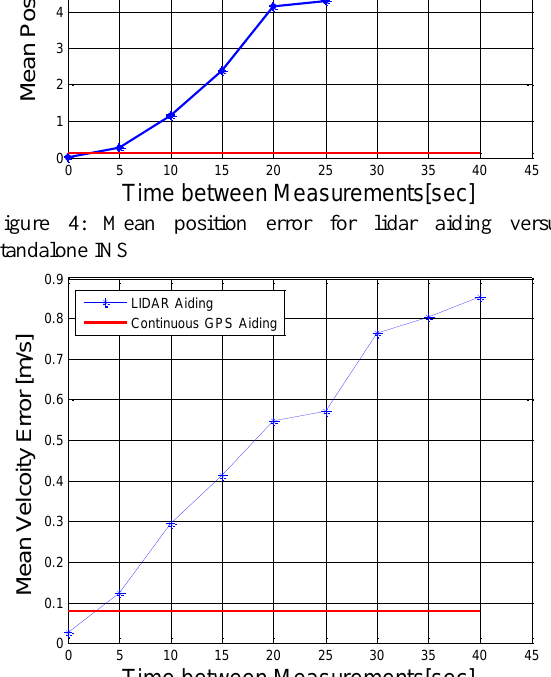
Figure 5: Mean velocity error for lidar aiding versus standalone INS